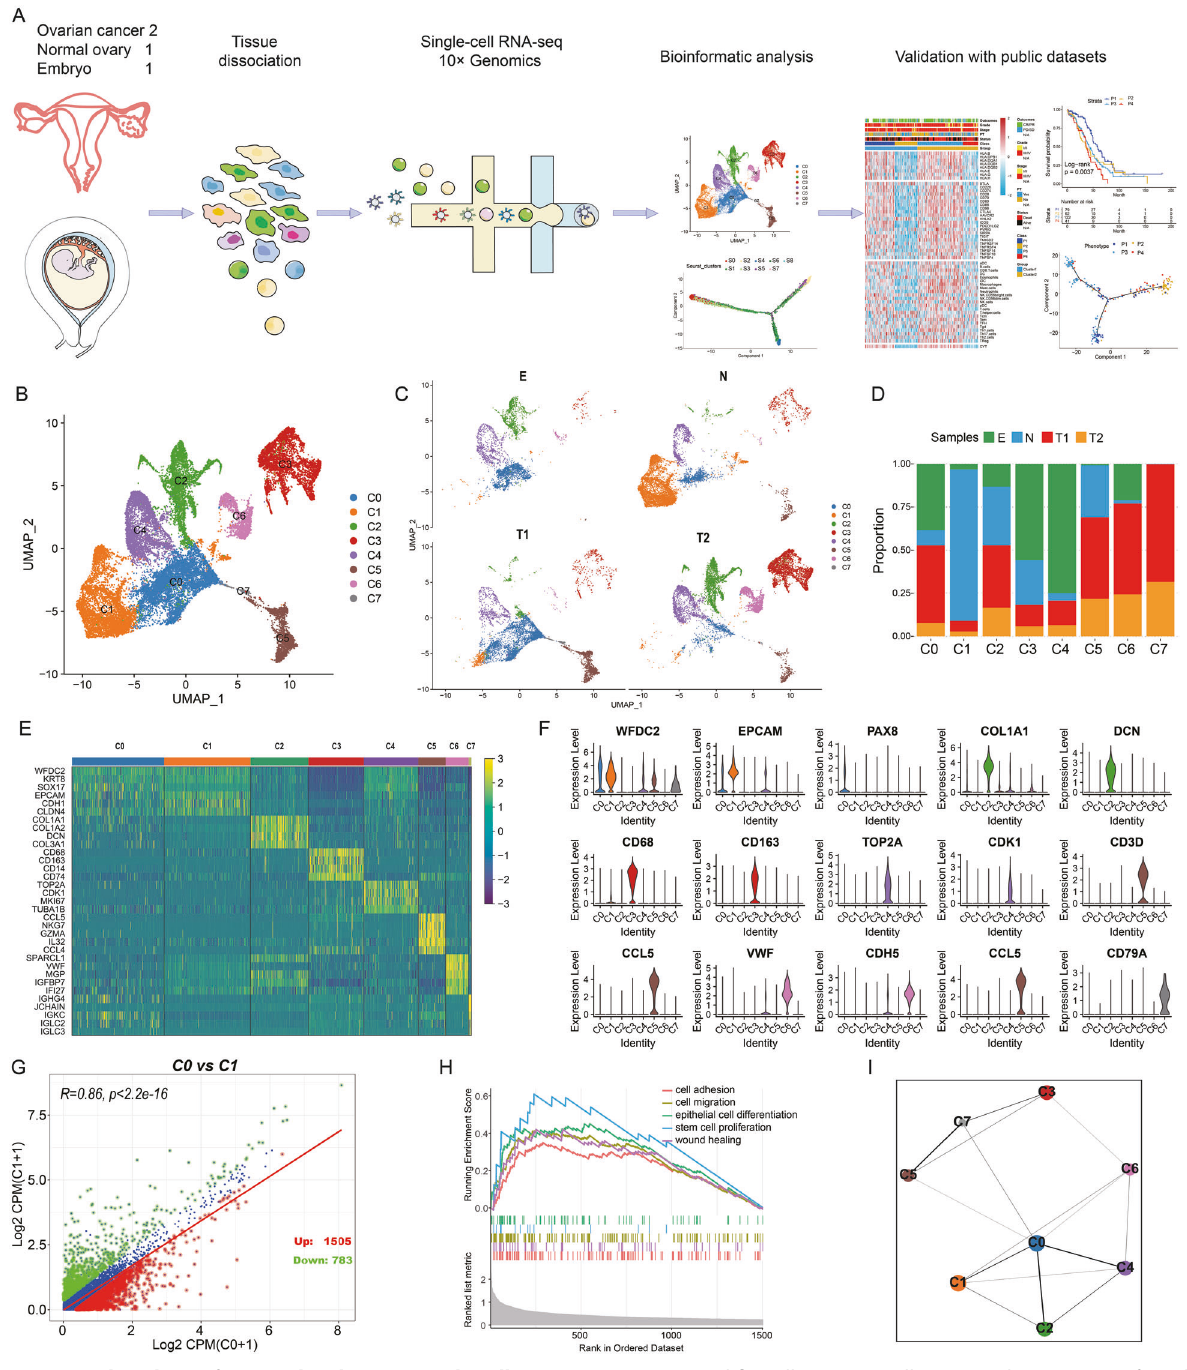
Fig. 1 Integrated analysis of OCs and embryonic single-cell transcriptomes. A Work fl ow illustrating collection and processing of single-cell transcriptome of OCs, control ovary, and embryo. B , C OCs and embryo cell clusters from 10× Genomics scRNA-seq analysis visualised by UMAP. D The proportion of diverse cell types across different samples. E Heatmap displaying the expression patterns of speci fi c markers in each cell type. F Violin plots exhibiting the expression of representative markers across diverse cell types. G Scatter plots showing the gene expression patterns of type C0 ( x axis) and C1 ( y axis). H GSEA analysis of C0 displaying its ’ malignant characteristics. I Relationship of C0 and other cell CSCs are closely related with chemotherapy and radiation levels, SOX2, NANOG, and OCT4 were also lower in siPEG10 cells therapy resistance. In our study, we found that PEG10 was higher (Fig. 4K). Moreover, downregulation of PEG10 inhibited multiple in the cisplatin resistance (Fig. 4F) and relapse group (Fig. 4G). OC cell line proliferation, such as CAOV8, A2780, and SKOV3 (Fig. GO_RESPONSE_TO_CISPLATIN was more enriched in PEG10-high 4E). Thus, suf fi cient evidence demonstrated that PEG10 de fi ciency group using the GSVA algorithm (Fig. 5H). Then Cell Counting Kit-8 had a profound impact on stem cell self-renewal by inhibiting (CCK-8) assay and fl ow cytometry were performed to discuss the genes involved in pluripotency.